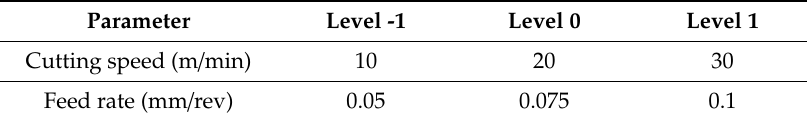
Figure 4. ( a ) General arrangement of the equipment used for the drilling tests. ( b ) Front and side view of the used tools. Table 3. Cutting conditions for the drilling experiments.